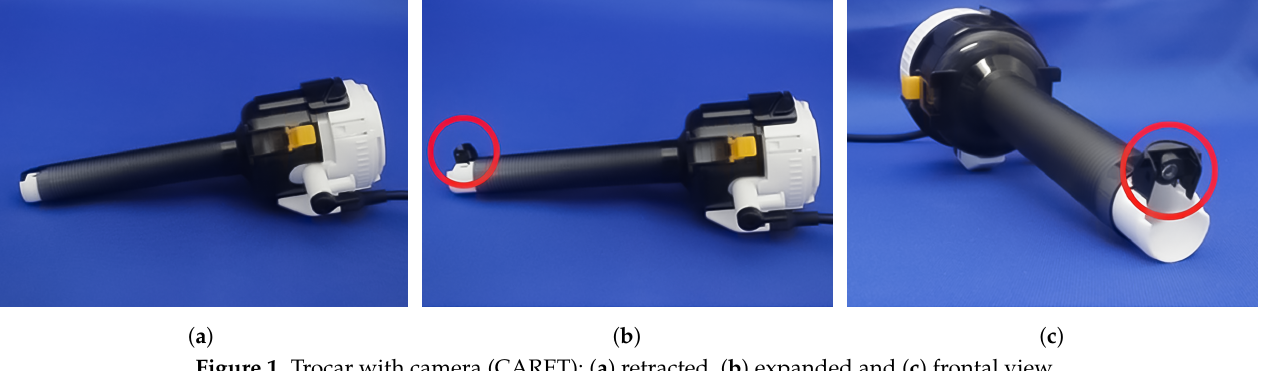
Figure 1. Trocar with camera (CARET): ( a ) retracted, ( b ) expanded and ( c ) frontal